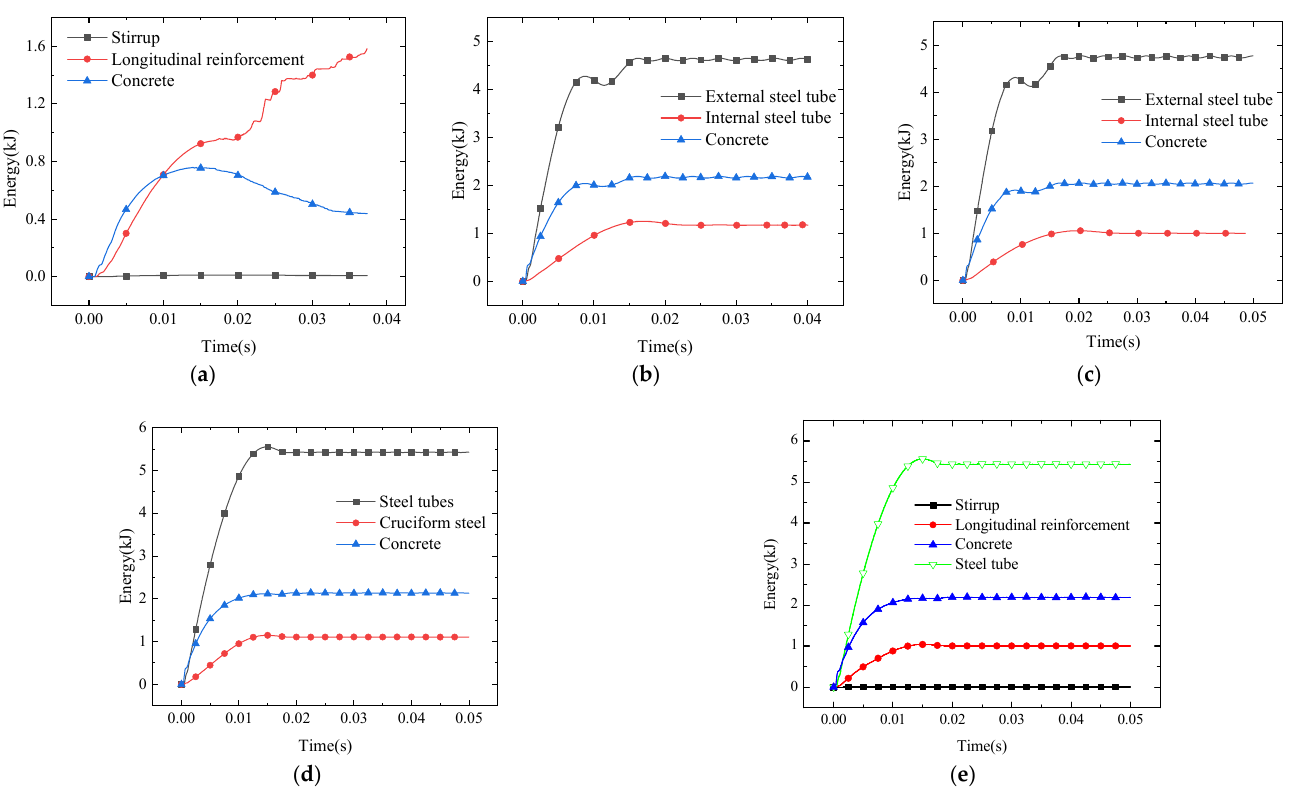
Figure 10. Energy–time history curve. ( a ) RC; ( b ) H-DS; ( c ) S-DS; ( d ) S-ST; ( e ) R-ST.